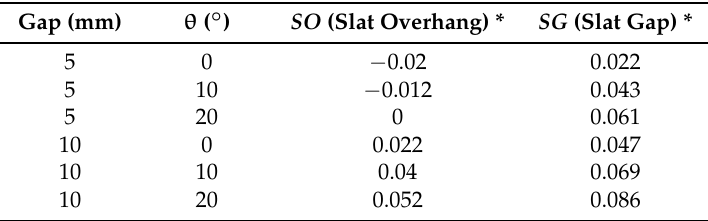
Table 1. Relation between current and standard slat nomenclature.